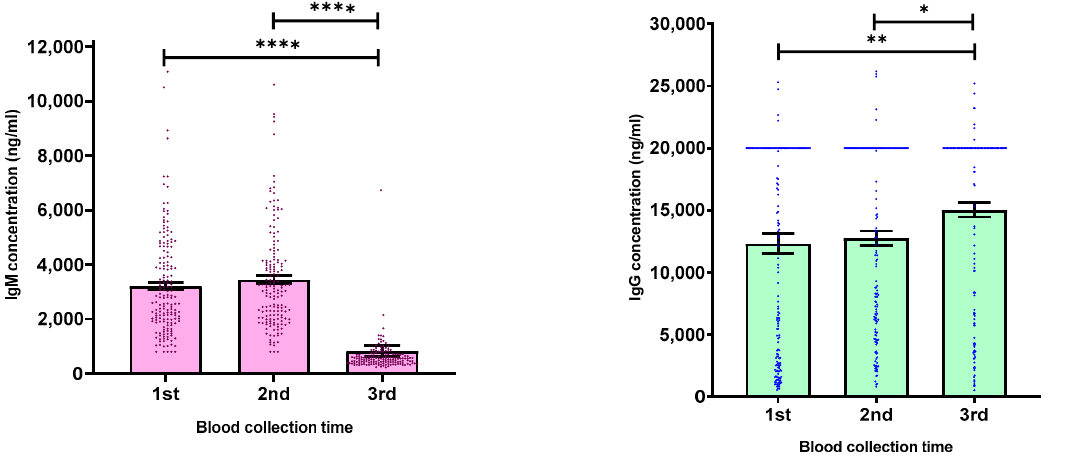
toms; 24.7% had symptoms after vaccination rather than injection site pain (Table 5).